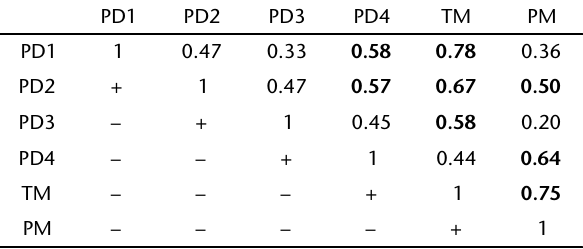
Table III. Beta diversity between the six breeding ponds sampled in Icém, São Paulo, Brazil, between September 2004 and August 2005. The highest beta diversity values recorded are indicated in bold.